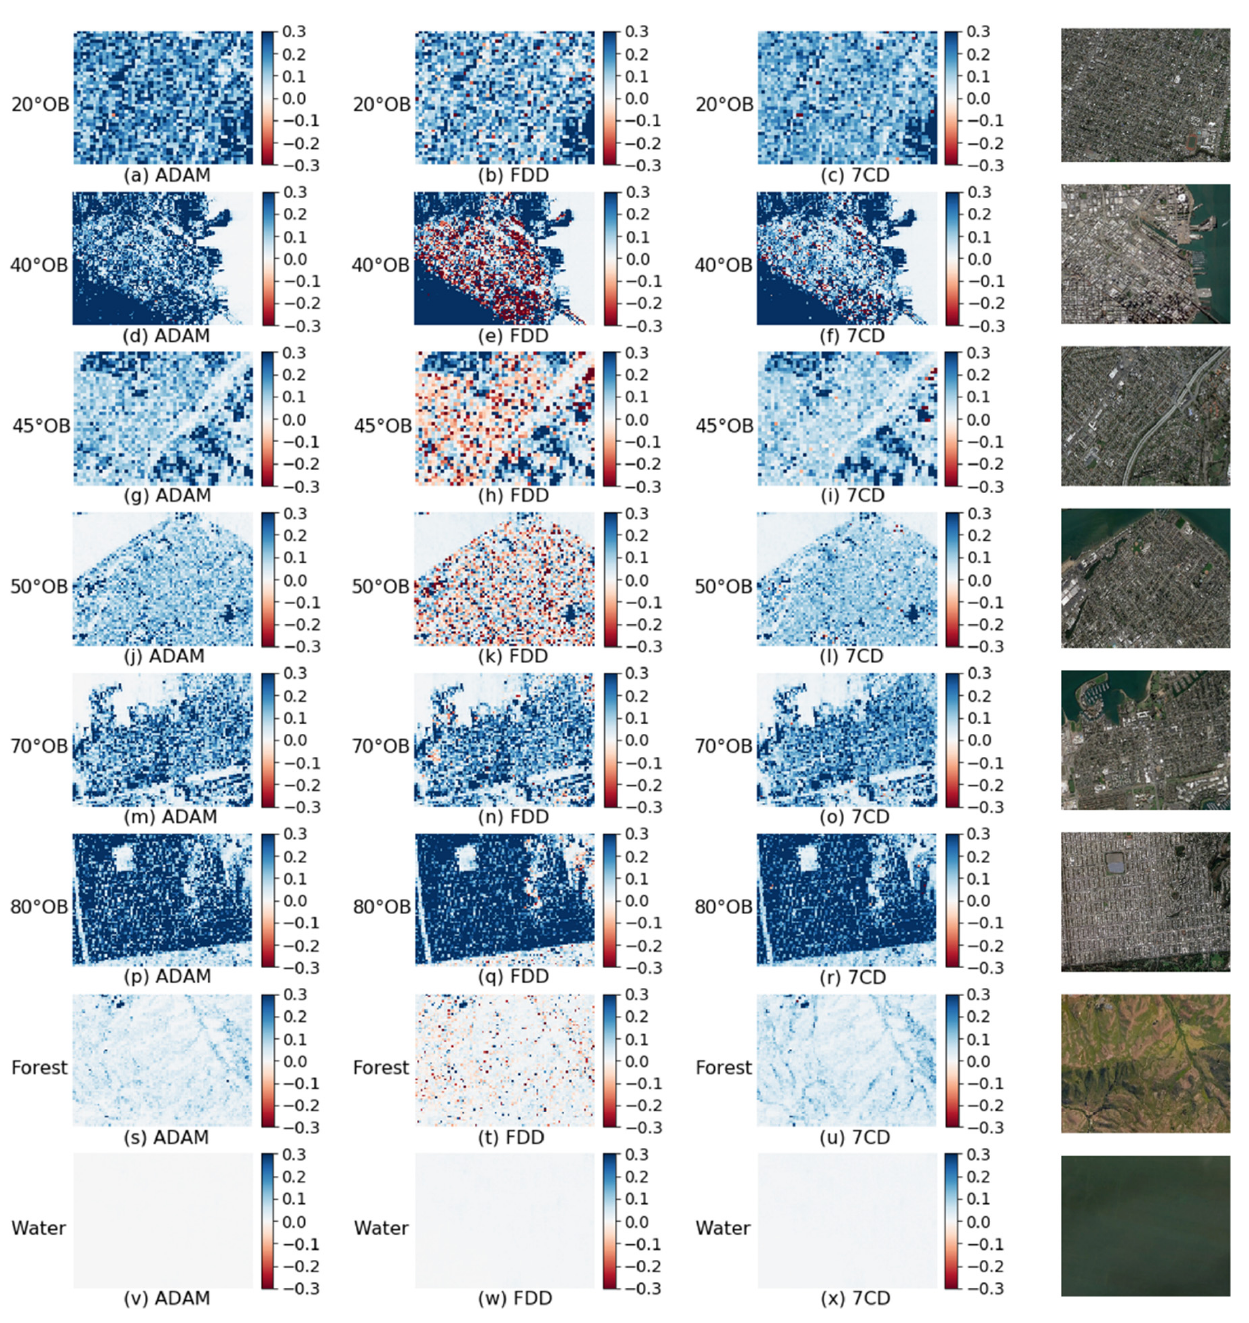
Figure 14. The output map of double-bounce scattering power P d estimated by ADAM, FDD, and 7CD for 8 types of samples over San Francisco, USA.